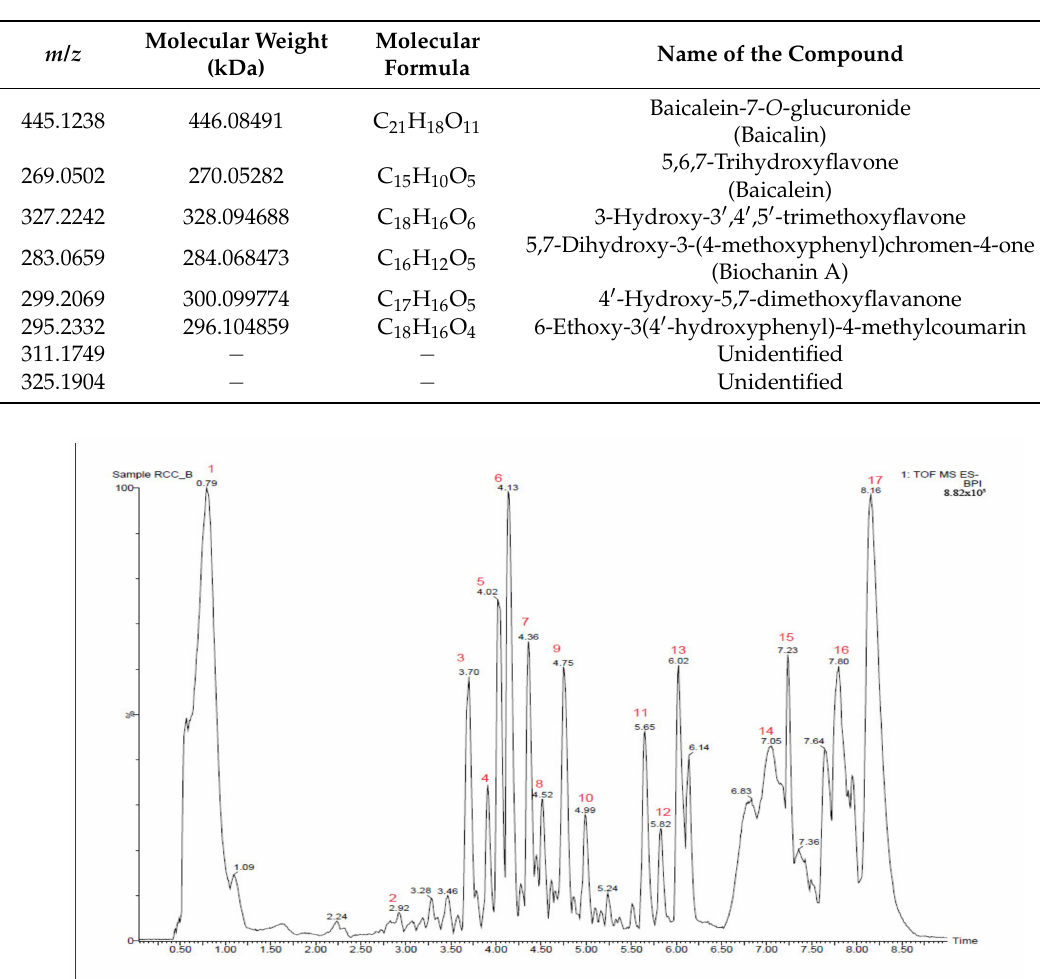
Figure 1. Total ion chromatogram of O. indicum Vent. wild root bark (OIM) extract subjected to UPLC-Q-TOF-MS analysis. The compounds corresponding to the peak numbers are listed in Table 1.